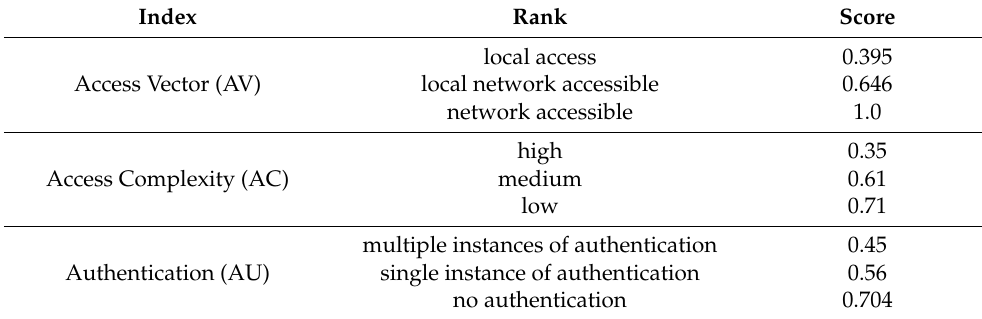
Table 1. Exploitable